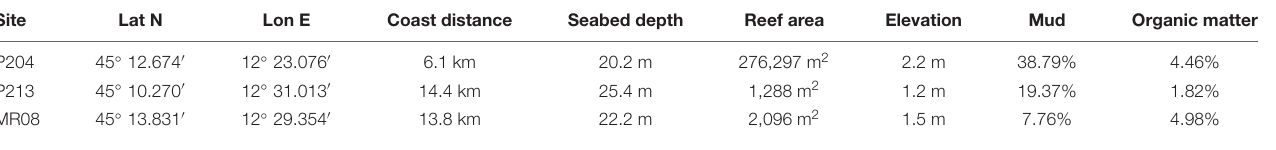
TABLE 1 | Location of the study sites (geographical coordinates, datum WGS84), and their distance from the coast, surrounding seabed depth (referred to the mean lower low water), area and max elevation of the reefs, mud and organic matter (as a percentage of loss on ignition at 450 ◦ C in 8 h) in the surrounding sediments. Site Coast